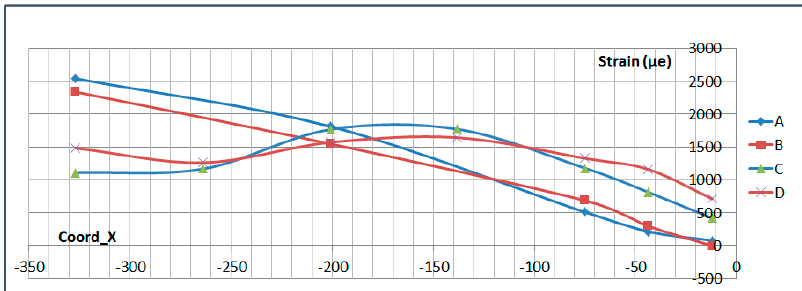
Figure 22. Strain Data along OF in Compression ( − 300 kN).